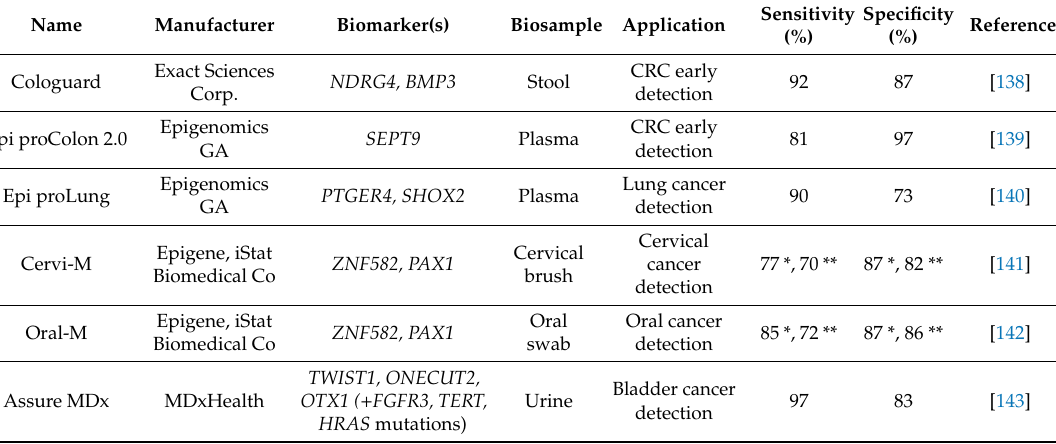
Table 1. Characteristics of clinically approved DNA-methylation assays for the detection of di ff erent type of